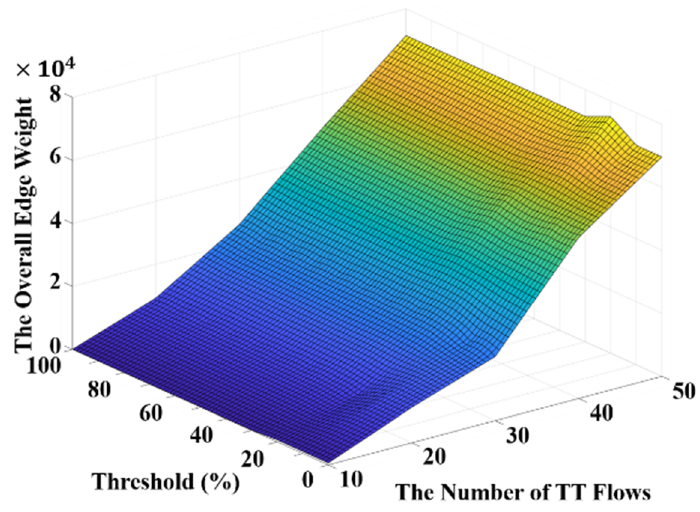
ff erent numbers of